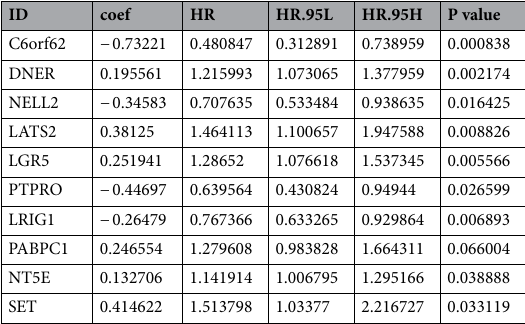
Table 2. Independent factors in the signature.